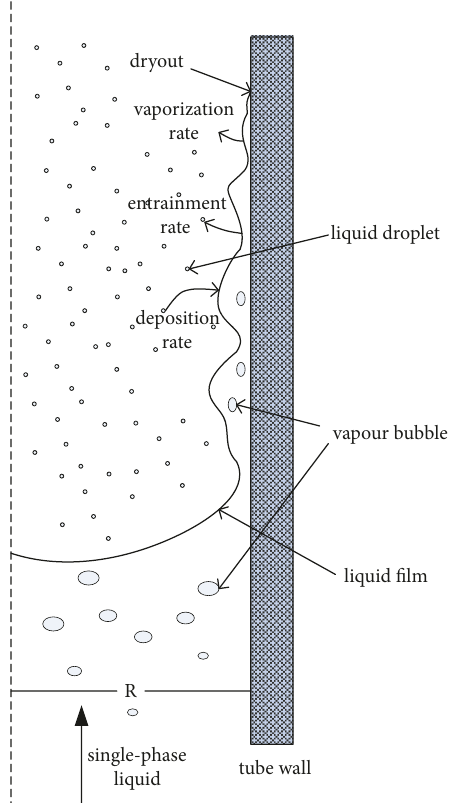
Figure 4: Schematic diagram of DO